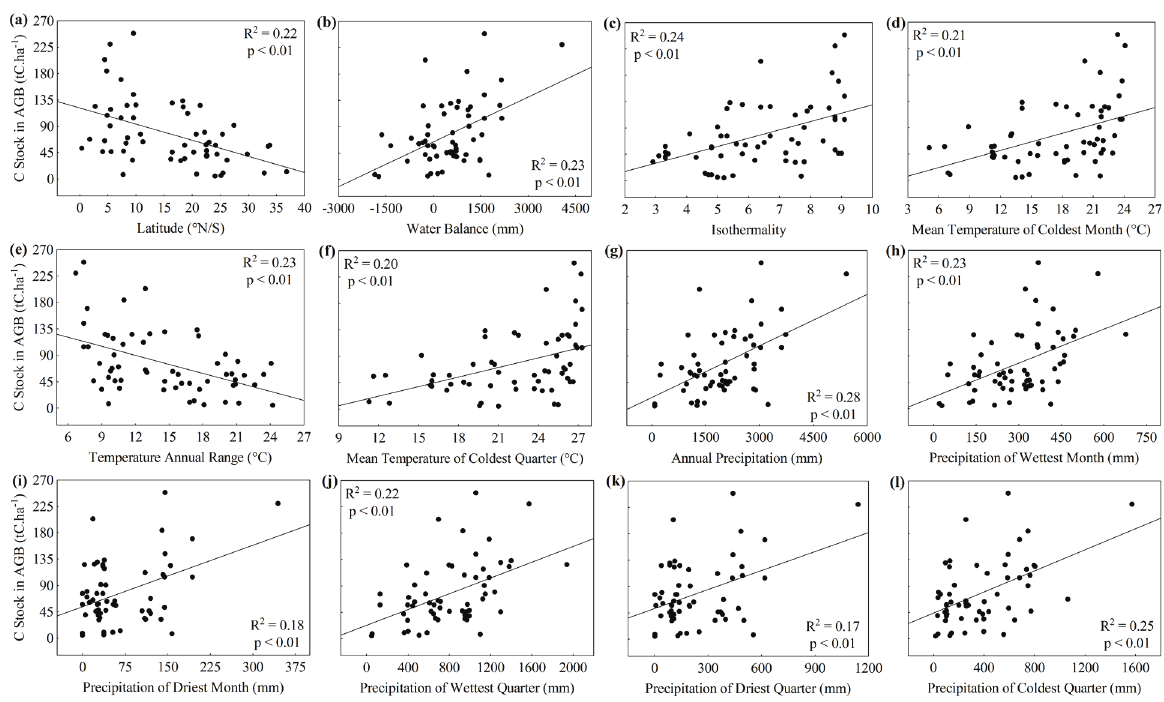
Figure 3 - Regressions between carbon stock and: ( a ) latitude; ( b ) water balance; (c) isothermality; ( d ) mean temperature of coldest month; ( e ) temperature annual range; ( f ) mean temperature of the coldest quarter; ( g ) annual precipitation; ( h ) precipitation of wettest month; ( i ) precipitation of driest month; ( j ) precipitation of wettest quarter; ( k ) precipitation of driest quarter; ( l ) precipitation of coldest quarter. See Table II for the regression